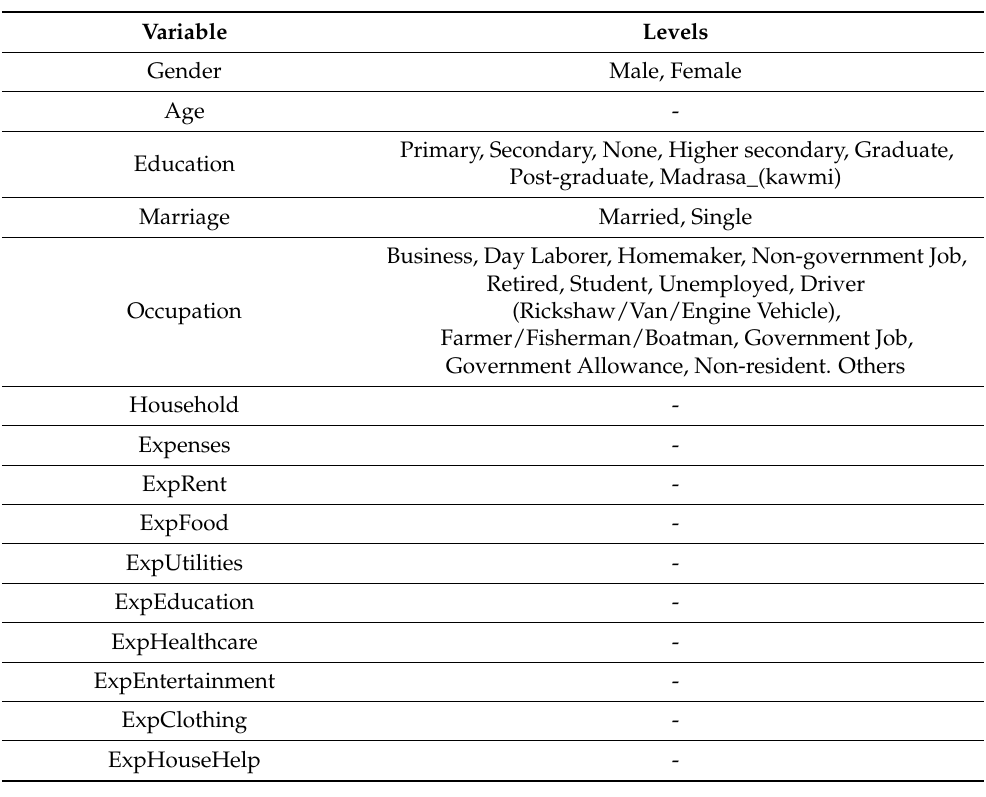
Table A2. List of variables used in the model and their